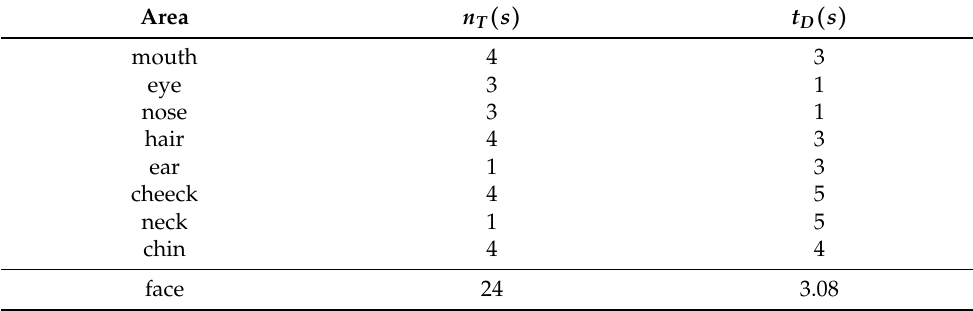
Table 1. The result of the face-touching habit observation reported in [4], where n T ( s ) and t D ( s ) denote the average number of face-touching per hour and average duration range in sec., respectively. Area n T ( s ) t D ( s ) mouth 4 3 eye